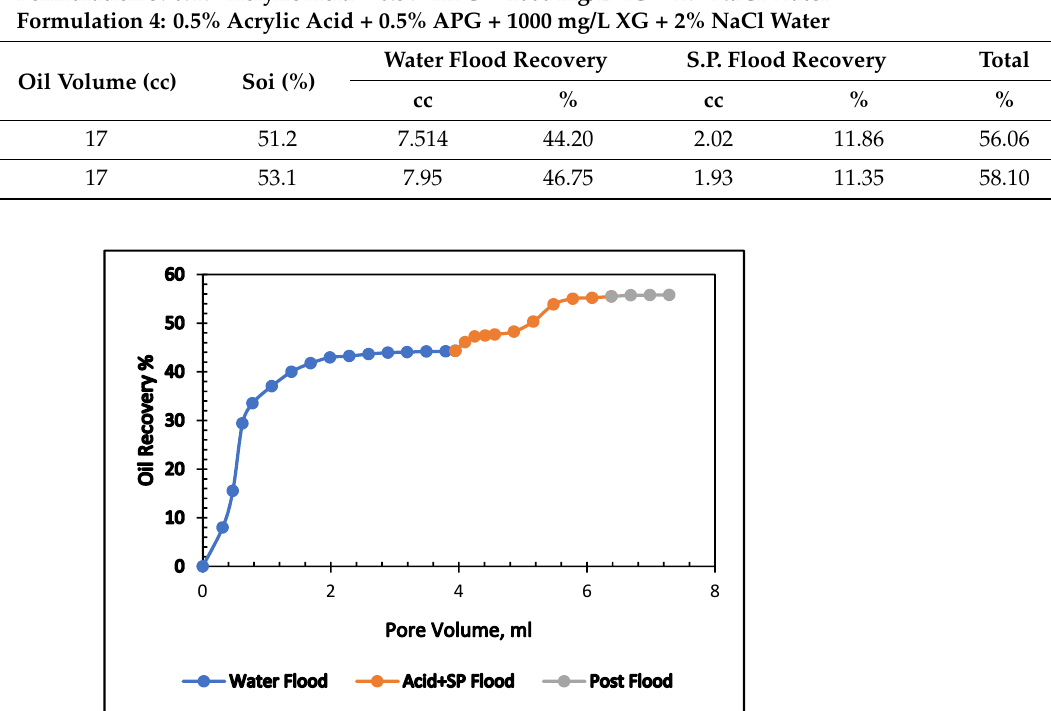
Table 8. Flood results for acrylic acid, APG 264, and Xanthan gum blend.